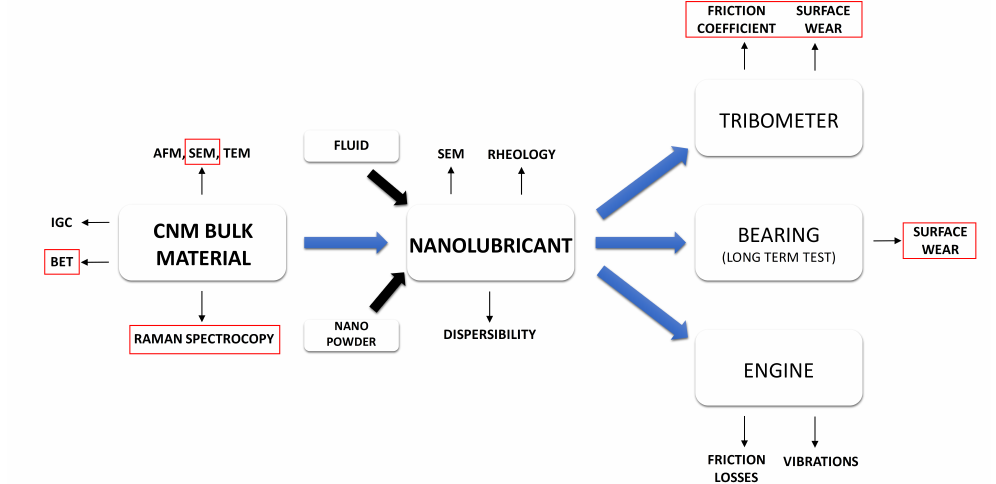
Figure 2. General idea of manufacturing nanolubricants and testing CNTs (only red-framed contents are discussed in this paper in detail as